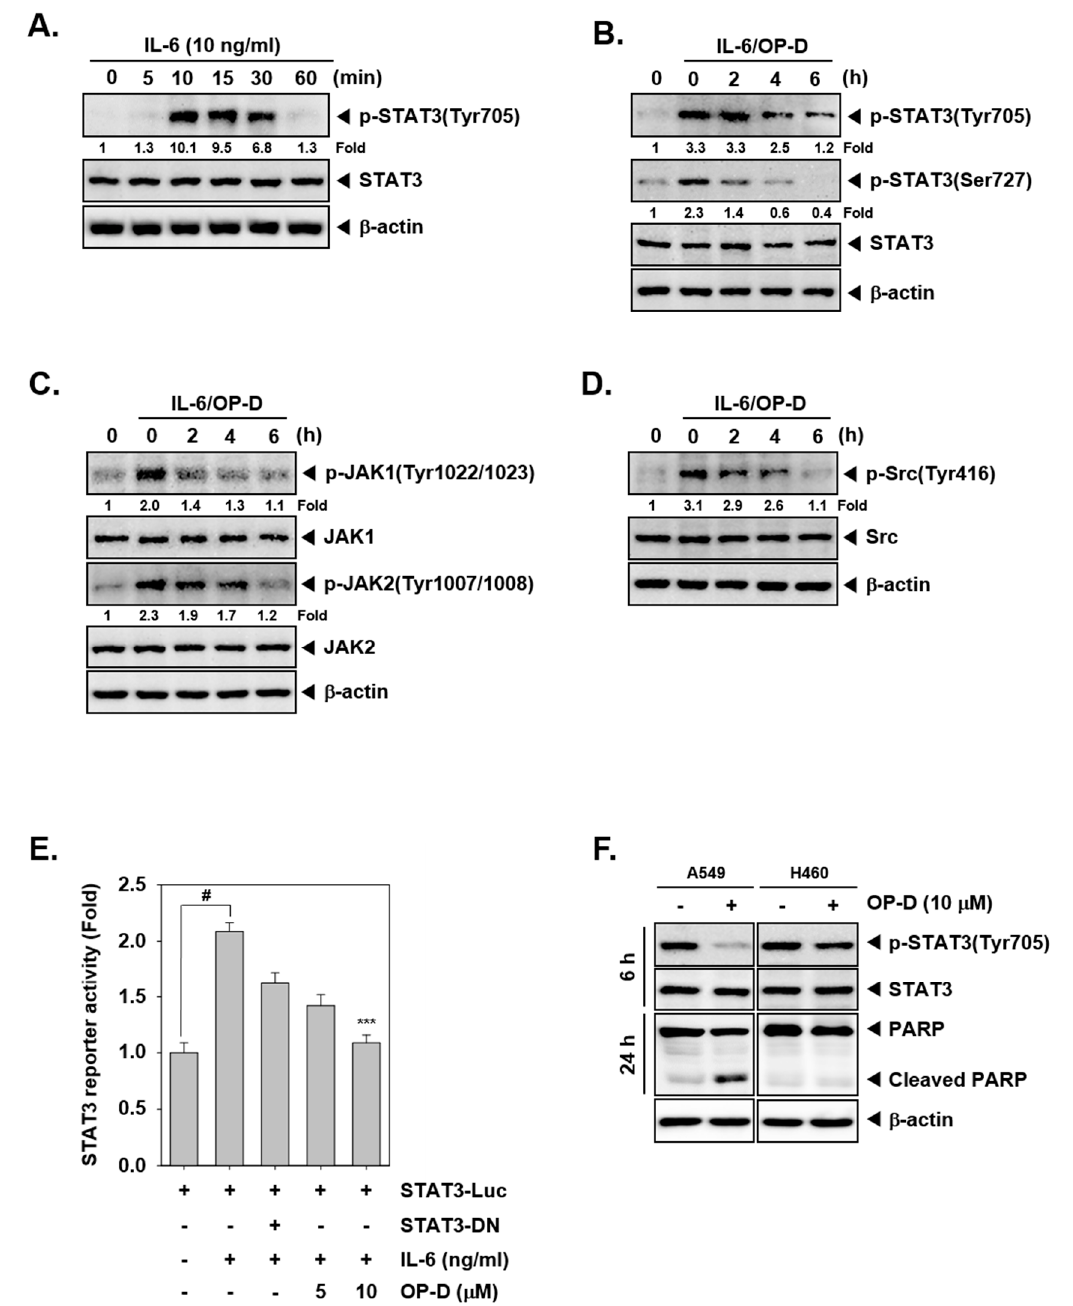
Figure 2. OP-D inhibits IL-6-induced STAT3 activation. ( A ) H1299 cells were treated with IL-6 (10 ng/mL) for the indicated time intervals and Western blot was performed. ( B – D ) H1299 cells were treated with 10 µ M of OP-D for the indicated times and then stimulated with IL-6 (10 ng/mL) for 15 min and Western blot was done with various proteins. ( E ) H1299 cells were transfected with STAT3-luciferase pretreated with OP-D for 6 h, then simulated with IL-6 and luciferase activity was measured. The results shown are representative of three independent experiments. # p < 0.05; *** p < 0.001. Abbreviation: DN = dominant negative. ( F ) A549 and H460 cells were treated with 10 µ M of OP-D for 6 h or 24 h and Western blot was